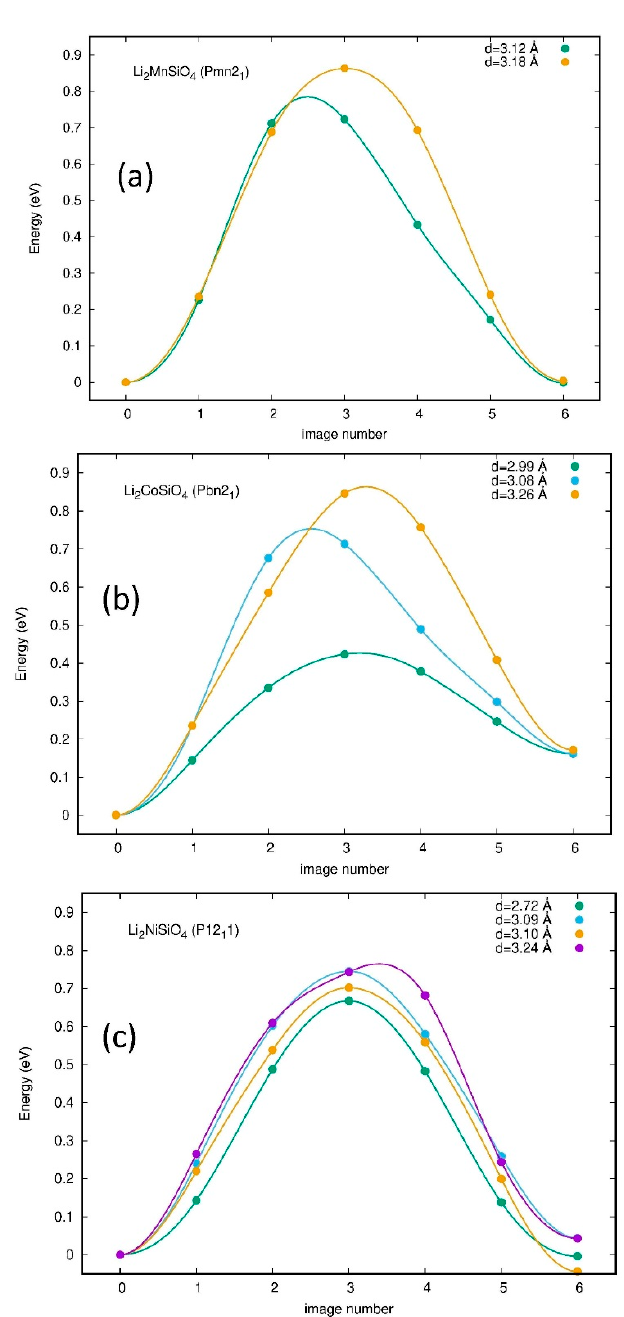
Figure 11. Li ion migration in different possible path ways in ( a ) Li 2 MnSiO 4 ( Pmn 2 1 ), ( b ) Li 2 CoSiO 4 ( Pbn 2 1 ), and ( c ) Li 2 NiSiO 4 ( P 2 1 ) obtained from NEB method. The connected lines are just to give a visual help of the sequence of images. The symbols represent calculated data points.